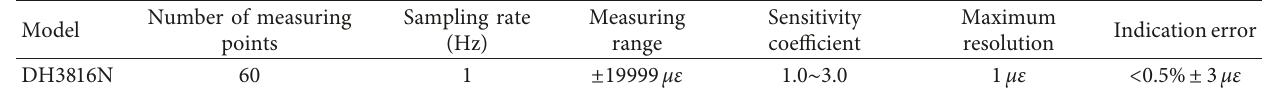
Figure 27: Monitoring during installation and jacking process. (a) The installation process monitoring. (b) The jacking process monitoring. Table 2: Main technical parameters of resistance strain